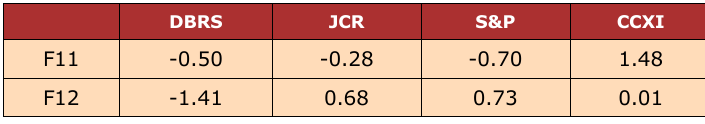
Table 5. The Scores of Principal Components